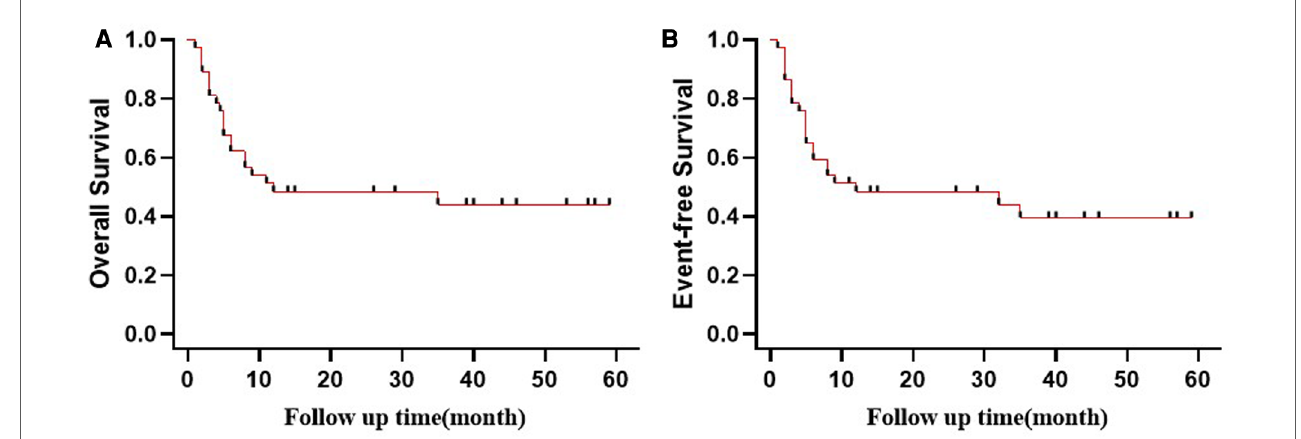
FIGURE 2 Probability of ( A ) OS and ( B ) EFS (Kaplan – Meier method) for patients strati fi ed by